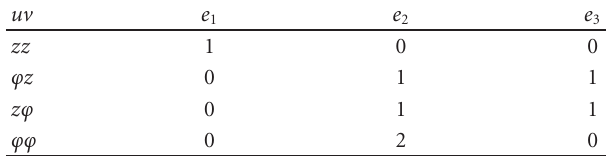
Table 1: The values of e 1 , e 2 , and e 3 for di ff erent uv .